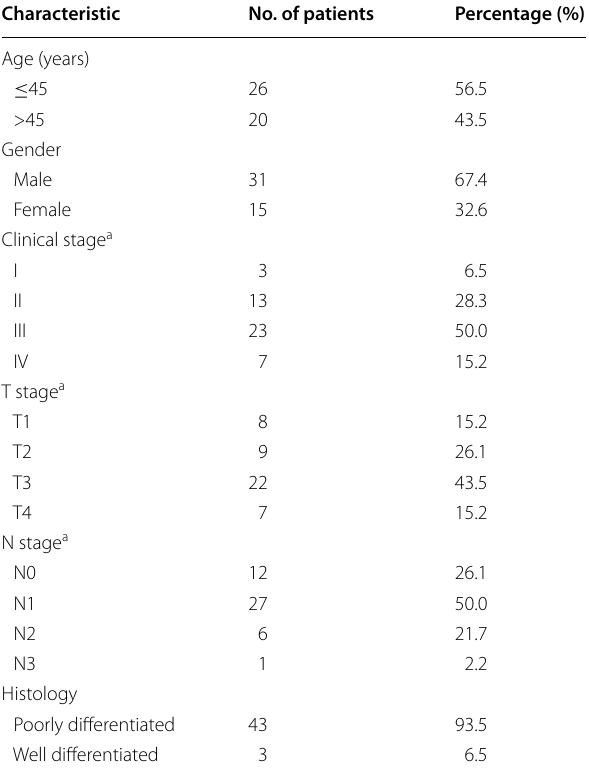
Table 1 Clinical characteristics of the 46 patients with nasopharyngeal carcinoma (NPC)